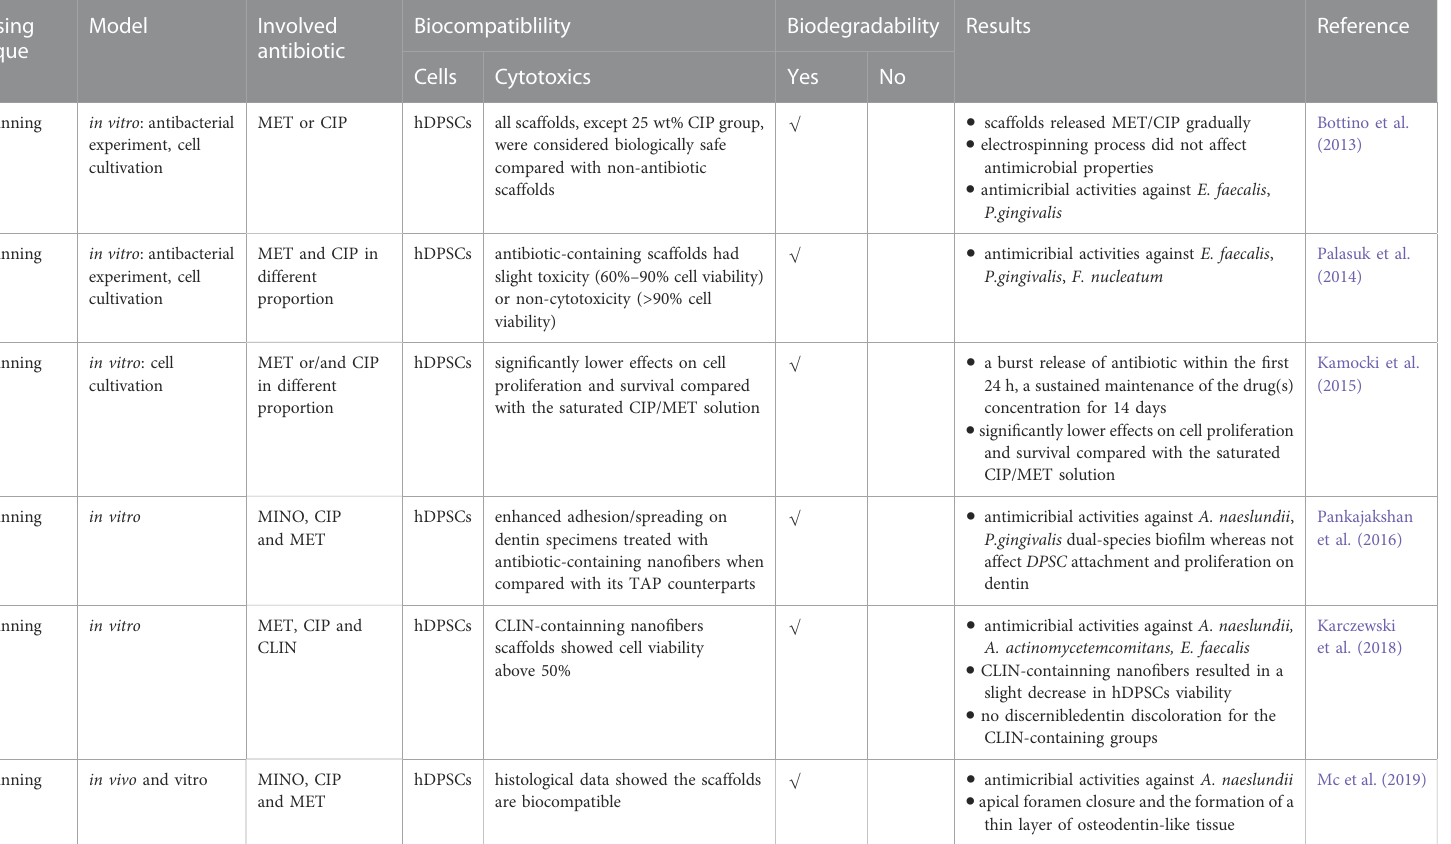
TABLE 1 Nano fi brous scaffolds for root canal